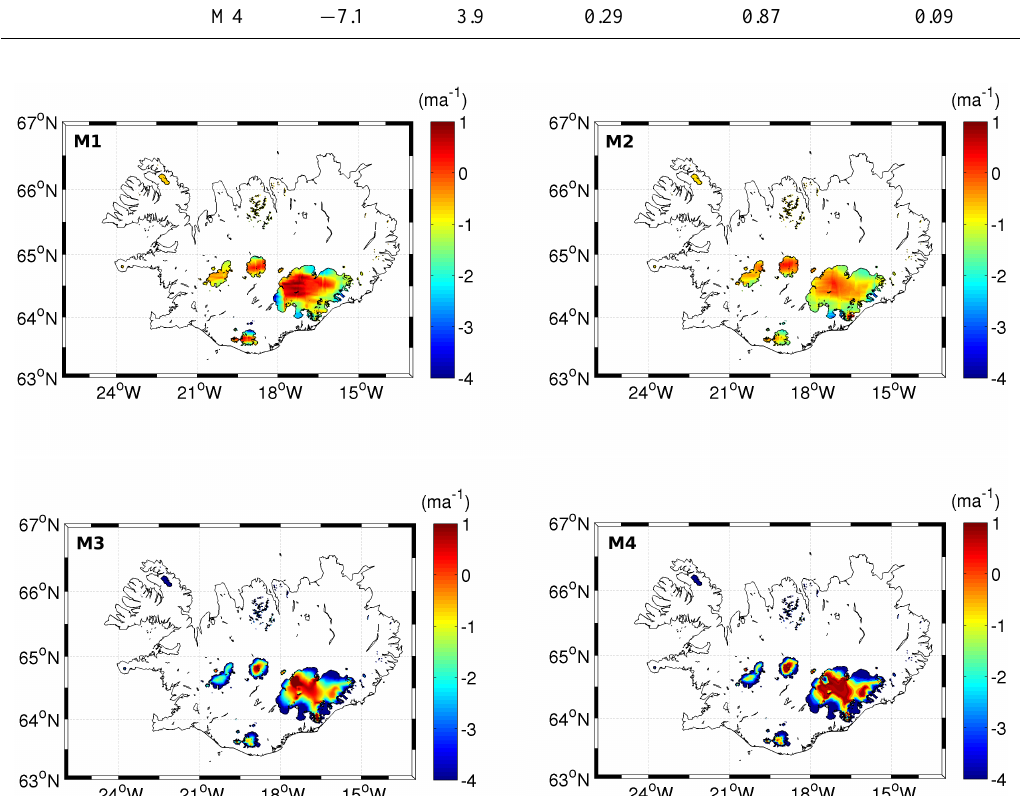
Figure 4. Regionalized elevation changes over Iceland from the M1–M4 methods showing the difference in estimated spatial patterns.